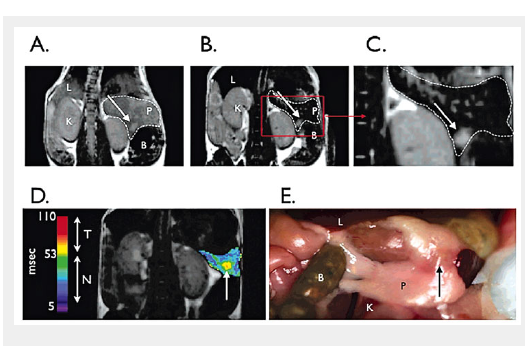
Magnetic resonance imaging (MRI) on T2-weighted sequences of pancreas and tumour. Preinjection (A) and postinjection (B) of pancreas and tumour. (C) Image from B at higher magnification. Bombesin-targeted nanoparticles permit tumour (arrows) to be seen. Arrow indicates bulk tumour. (D) Postcontrast agent, colorised T2 map of a pancreas with implanted tumour. Tumour has higher T2s than normal pancreas. Abbreviations: L, liver; P, pancreas; K, kidney; B, bowel. (E) Photograph of partially dissected mouse with pancreas and tumour